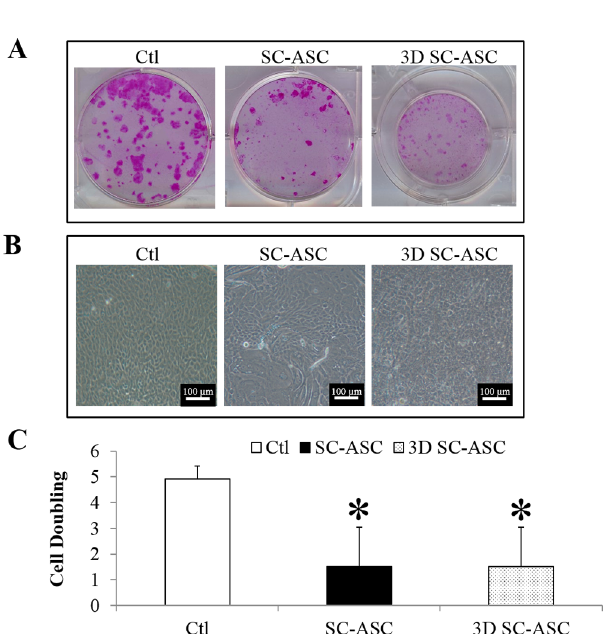
Fig 3. Single-cell suspension of limbal epithelial cells cultured on ASCs. (A) Cell morphologyof cultured LSCs. The images for SC-ASC and 3D SC-ASCwerefrom the 33%culturewhichsupported epithelial expansion. (B) Cellmorphology of culturedLSCs.The imagesfor SC-ASCand3D SC-ASCwerefrom the 33% culturewhichsupportedepithelialexpansion. (C) Celldoublingof limbalepithelialcells. * :p < 0.05in comparison with resultsof control.Ctl: control.SC-ASC: singlecellsuspensionof LECscultureddirectlyon ASCs.3D SC-ASC: singlecellsuspensionof LECsculturedon ASCsusingthe 3D method.Scalebar = 100 μ m.